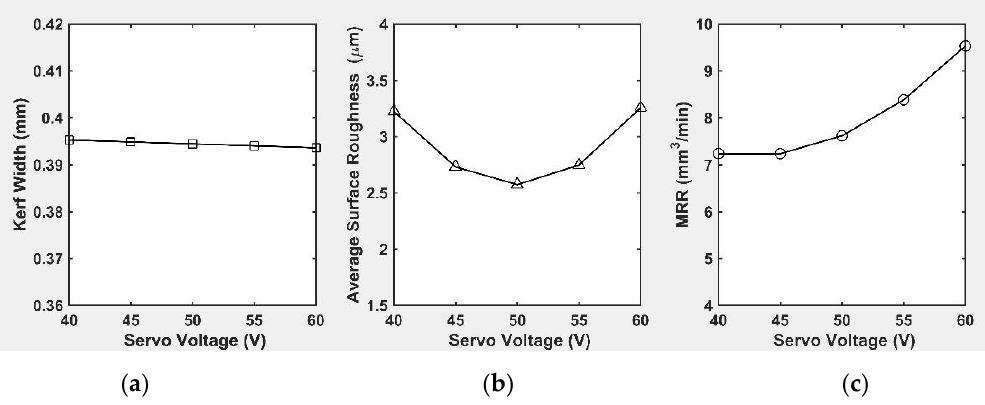
Figure 6. Effects of servo-voltage (SV) on ( a ) kerf width, ( b ) surface roughness, and ( c ) MRR.